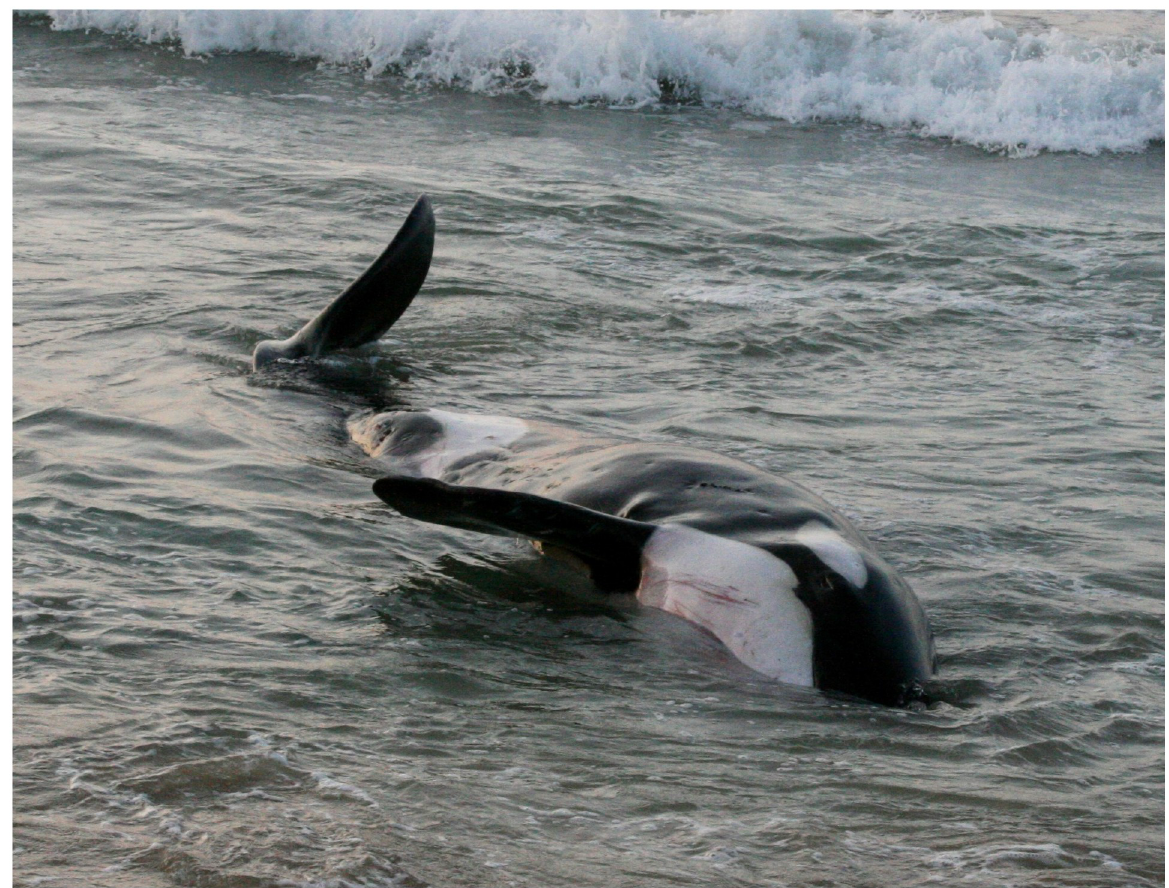
Fig 4. Emaciated female killer whale (ID# 20081021) from Hawaii. Note the depression behind the head at the location of the nuchal fat pad, prominent rib profiles in the thorax, and a thin tail stock.